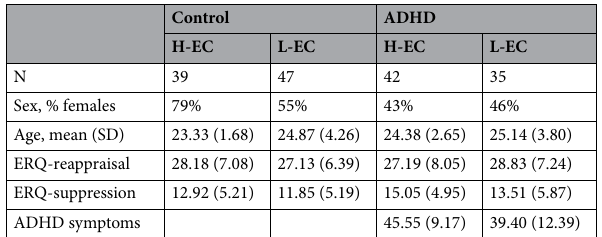
Table 1. Descriptive data for sex, age, trait emotion regulation, and ADHD symptoms for the ADHD symptoms and the control